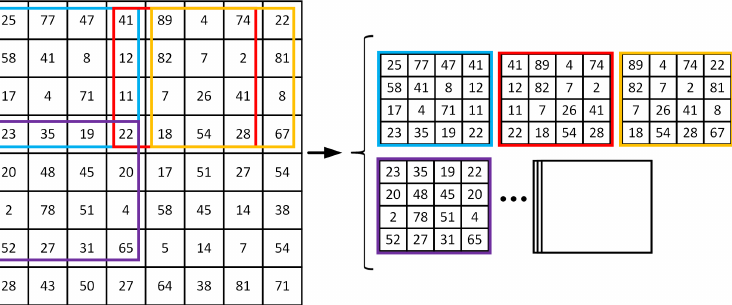
Figure 4. Predefined patch ( 4 × 4 ) size before representing features over entire